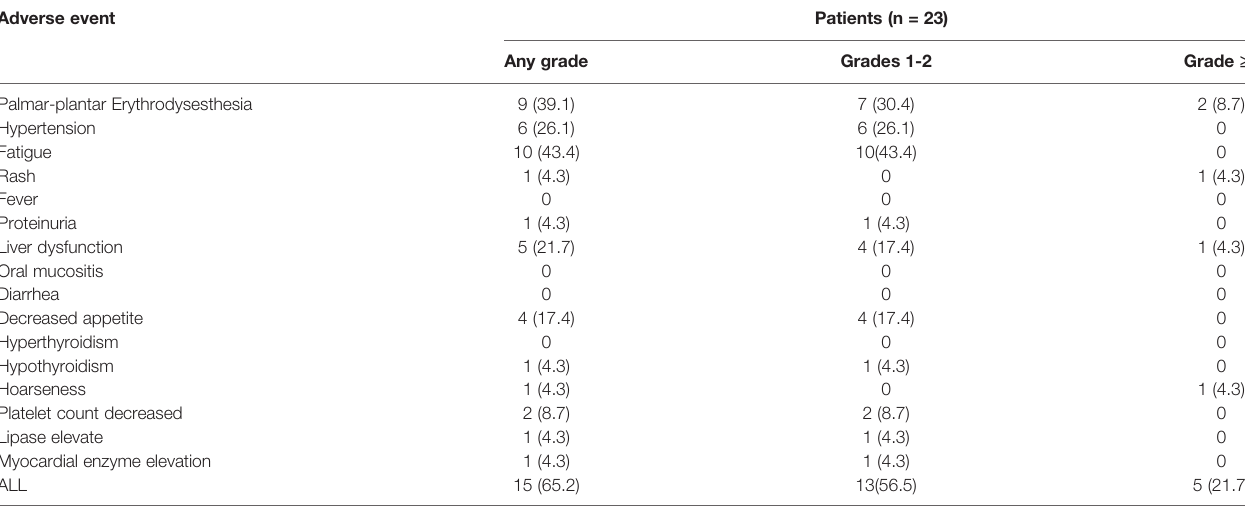
TABLE 3 | Adverse events of combination treatment of regorafenib and anti-PD-1 antibodies. Adverse event Patients (n = 23) Any grade Grades 1-2 Grade ≥ 3 Palmar-plantar